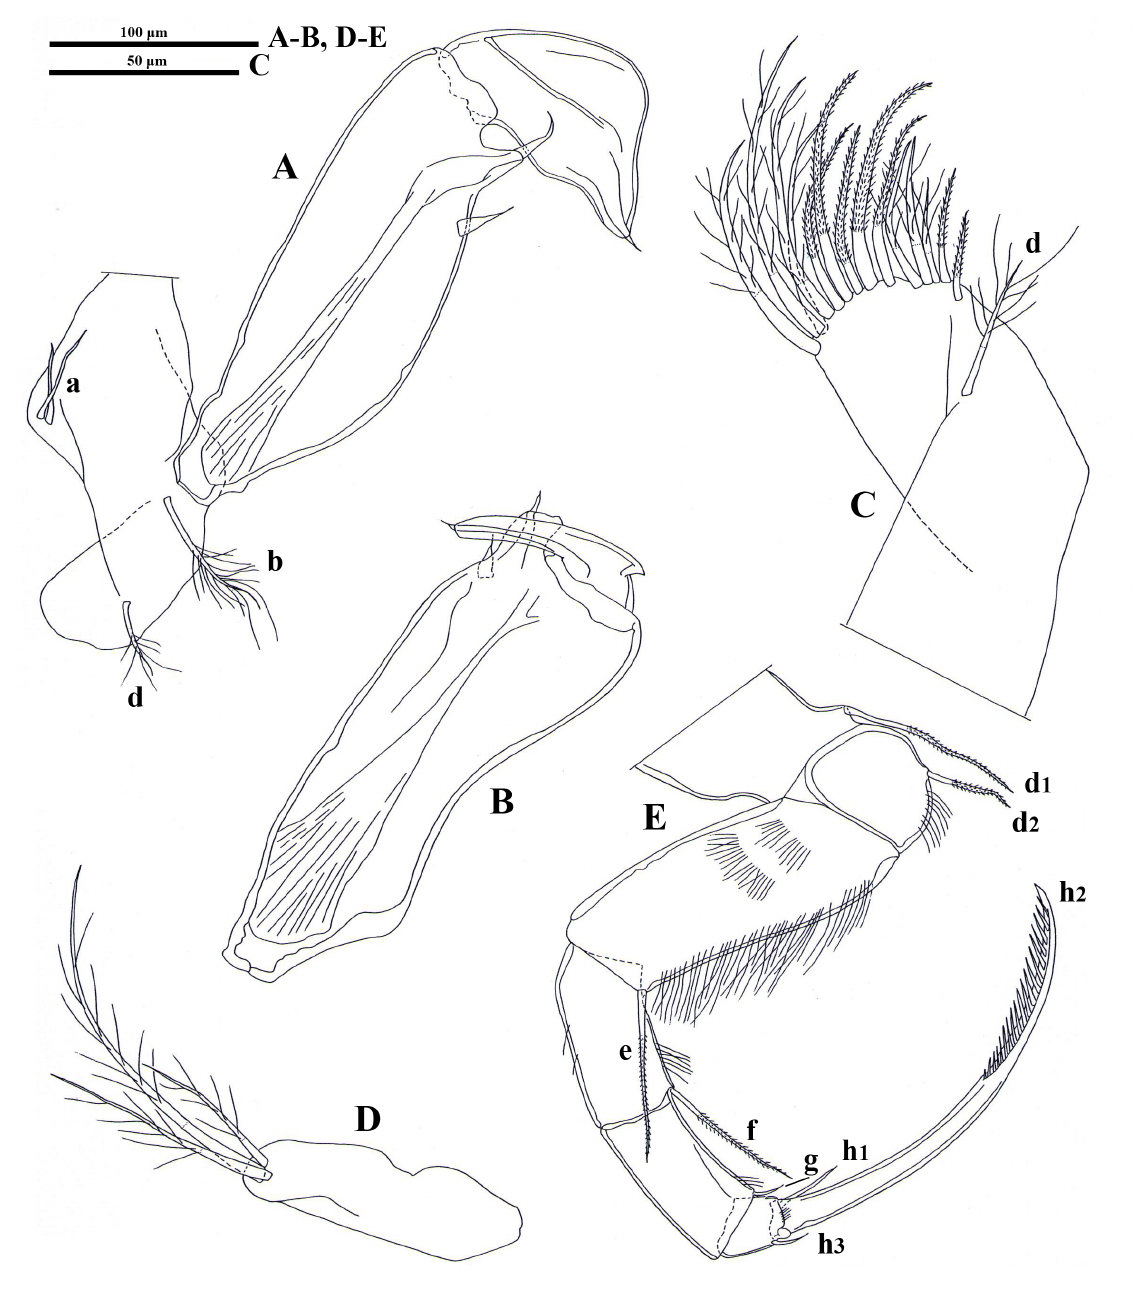
Fig. 6. Martensina thailandica gen. et sp. nov. A–C , E . Holotype, ♂ (MSU-ZOC.317). D . Allotype, ♀ (MSU-ZOC.318). A . Right T1. B . T1, left prehensile palp. C . T1 protopodite. D . T1 endopodite. E . T2. Scale bars: A–B, D–E = 100 μm; C = 50